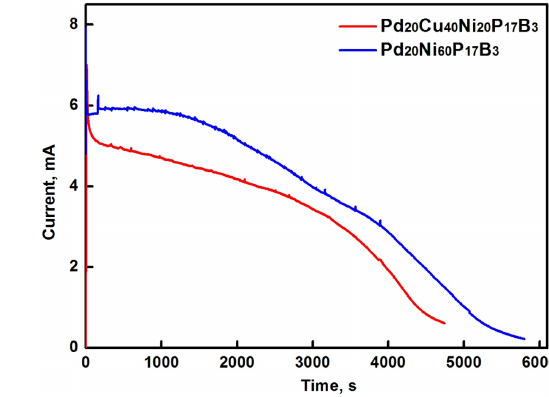
Ni P B and Pd Ni Cu P B 20 60 17 3 20 20 40 17 3 SO + 0.2 mol·L –1 H PO 2 4 3 4